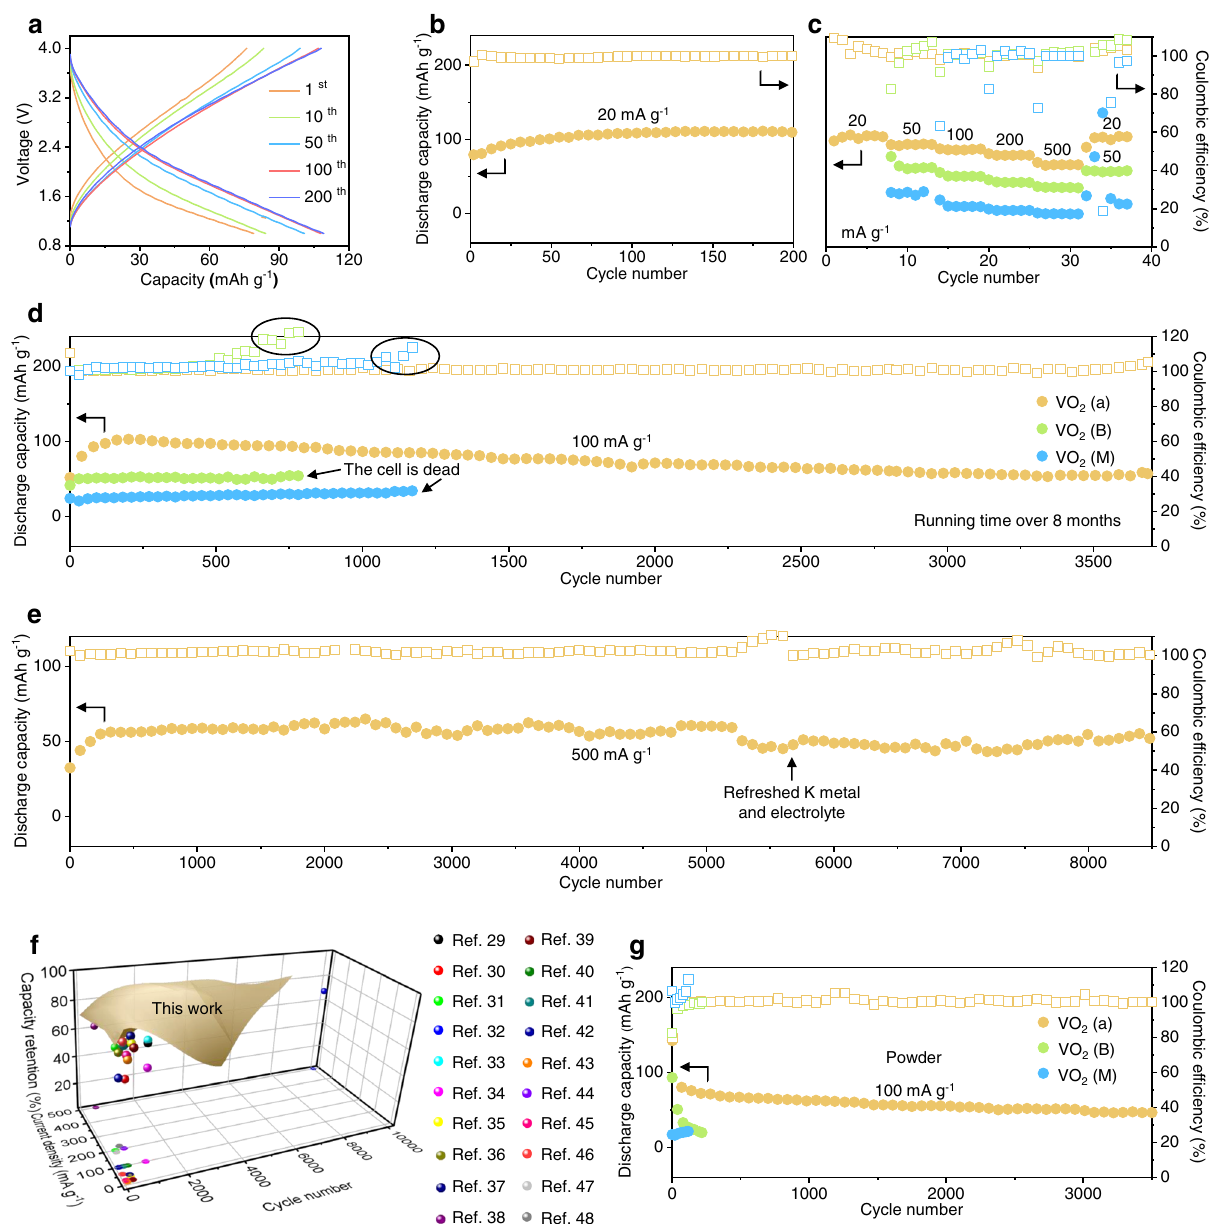
Fig. 3 | Electrochemical performance optimization via phase engineering. a Discharge/charge curves and b) cycling performance of VO 2 (a) at a speci fi c current of 20mAg − 1 . c Rate performance and ( d ) cycling performance of VO 2 (a), VO 2 (B), and VO 2 (M) at 100mAg − 1 . e Long cycle life performance of VO 2 (a) at